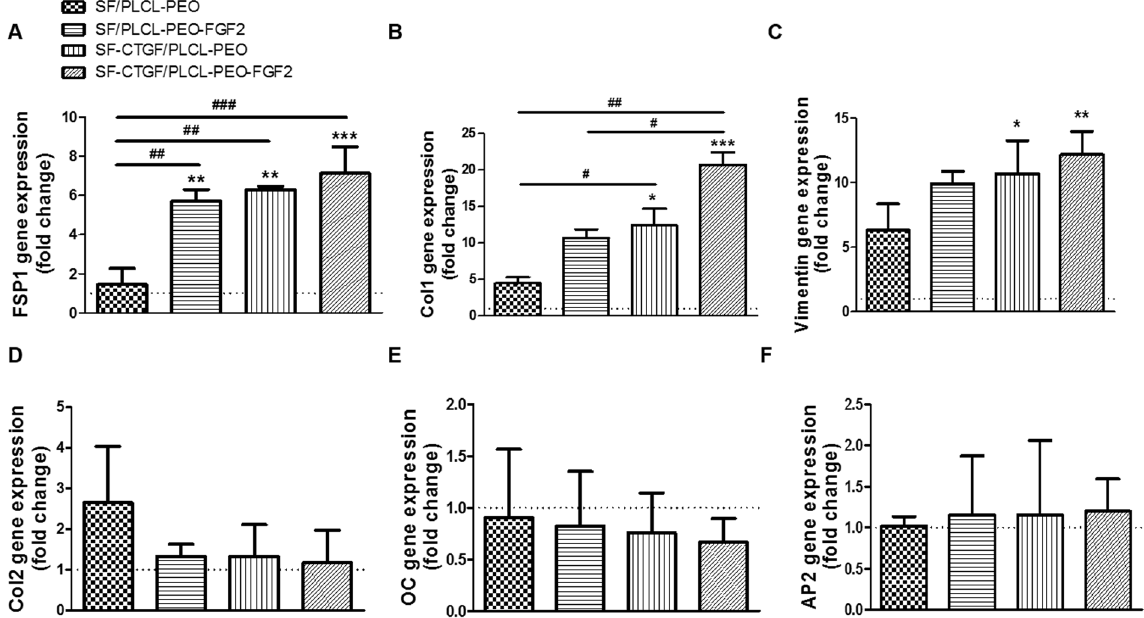
Figure 5. Quantitative gene expression levels of ( A ) FSP1 (a marker of fibroblast), ( B ) COL1 (a marker of fibroblasts), ( C ) VIMENTIN (a marker of fibroblasts), ( D ) COL2 (a marker of chondrocytes), ( E ) OC (a marker of osteoblasts) and ( F ) AP2 (a marker of adipocytes) in the cells cultured on different coaxial nanofibrous scaffolds compared with the levels observed on the TCP at week 1. (One-way repeated-measure Analysis of Variance test (ANOVA) were used to compare multiple groups. * , ** and *** : stand for significant difference between samples on scaffolds and samples on TCP with p < 0.05, p < 0.01 and p < 0.001, respectively; #, ## and ###: stand for significant difference among different scaffolds with p < 0.05, p < 0.01 and p < 0.001,